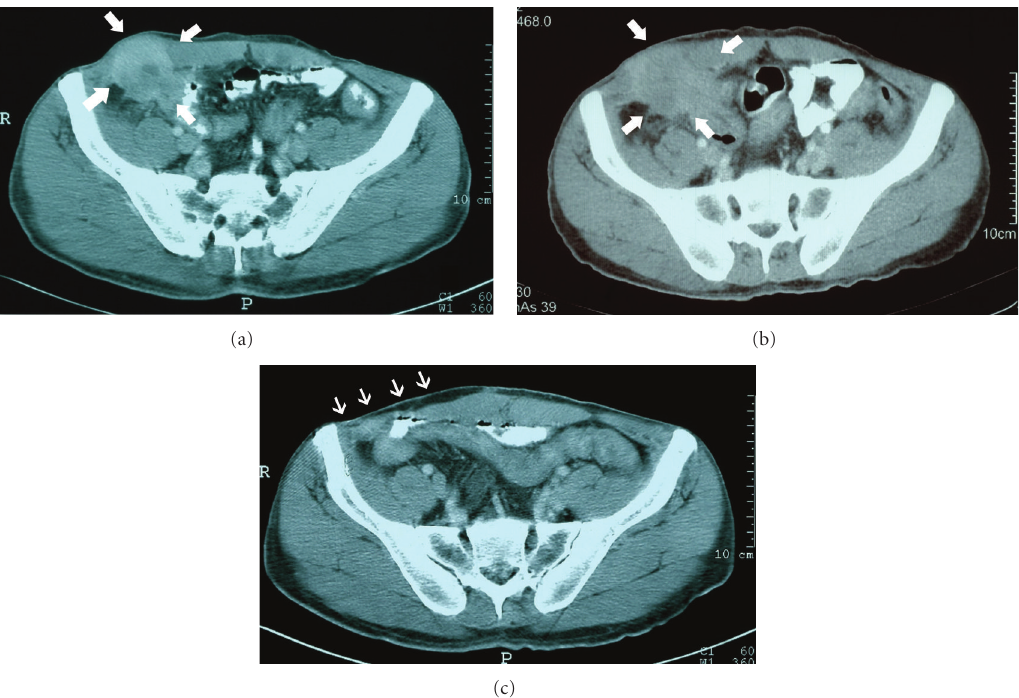
Figure 1: (a) The first CT of the patient before neoadjuvant chemotherapy. Thick arrows show the colonic mass, which invaded adjacent tissues including skin. (b) There was not enough mass regression after neoadjuvant therapy. (c) Excellent mesh adaptation at 6 months. Thin arrows highlight the mesh